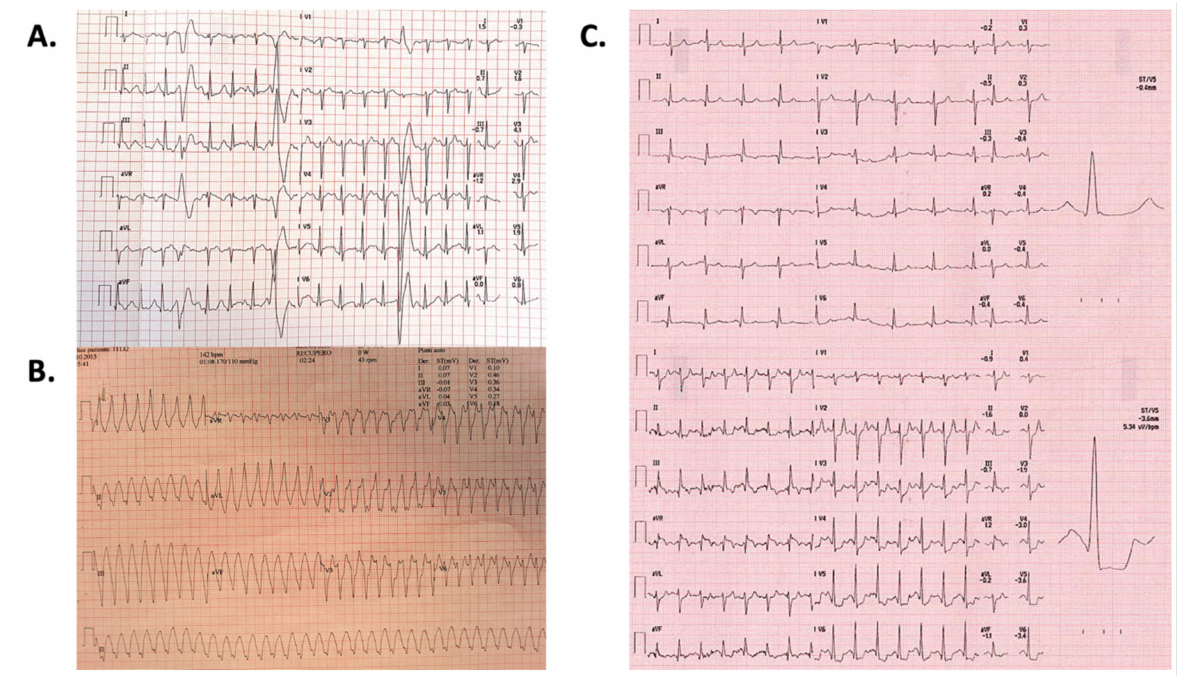
Figure 2. Exercise stress test findings. Representative examples of remarkable findings on exercise stress tests are shown. (Panel ( A )). Female patient, 32-year-old, with evidence of frequent polymorphic ventricular ectopies on the effort at exercise stress test performed 12 months after cardiac magnetic resonance-proven acute myocarditis presenting with nonsustained ventricular tachycardia and syncope. After the exercise stress test, he underwent an endomyocardial biopsy and subsequent immunosuppressive treatment for virus-negative lymphocytic myocarditis. (Panel ( B )). Male patient, 44-year-old (P123, Table 3) with evidence of sustained monomorphic ventricular tachycardia causing syncope during an exercise stress test performed late after presentation with arrhythmic myocarditis. The subsequent workup is shown in Table 3. (Panel ( C )). Male patient, 68-year-old (P37, Table 3) with exercise stress test showing dynamic ST segment depression in inferolateral leads with ST elevation in lead aVR (exercise peak, bottom; compared to baseline, top). He was asymptomatic for angina or dyspnea. After normal coronary angiography, he had both cardiac magnetic resonance and endomyocardial biopsy with a final diagnosis of chronically active myocarditis from parvovirus B19. Further details are reported in Table